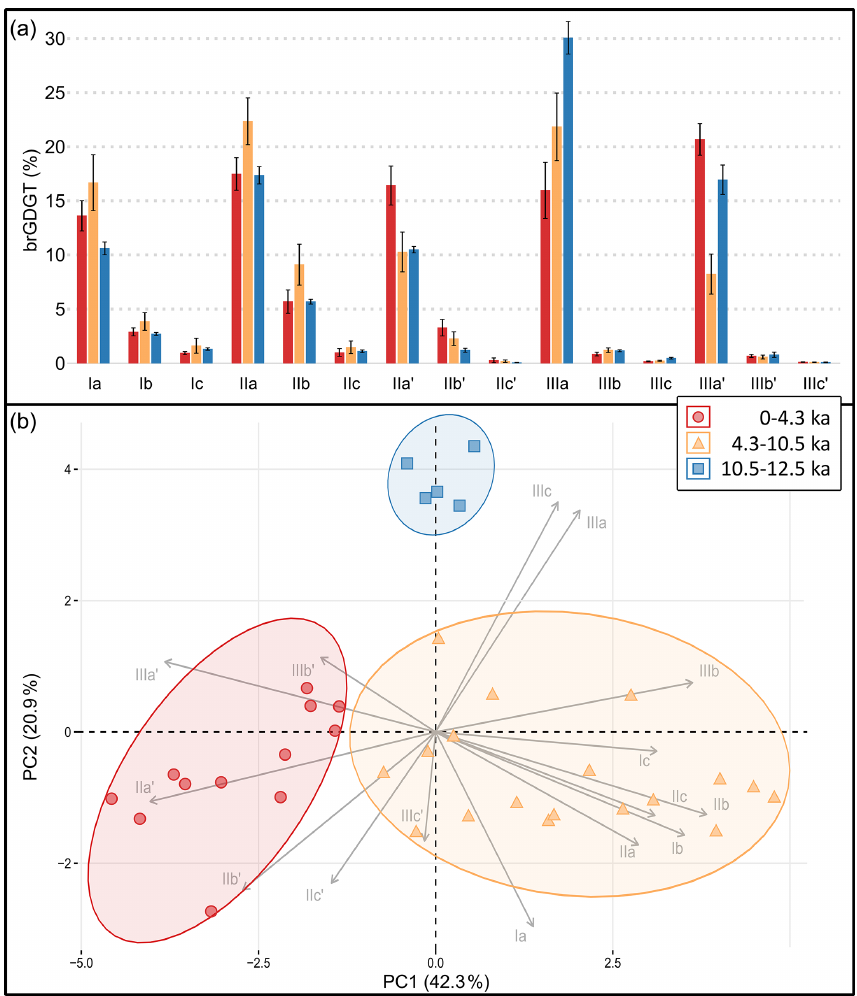
Figure 4. (a) Bar plot of average brGDGT percentages in the Garba Guracha sediment core, with standard deviation plotted as error flags; (b) PCA of brGDGTs of the Garba Guracha sediment core; data from 0 to 4.3kacalBP (red), 4.3 to 10.5kacalBP (orange), and 10.5 to 12.5kacalBP